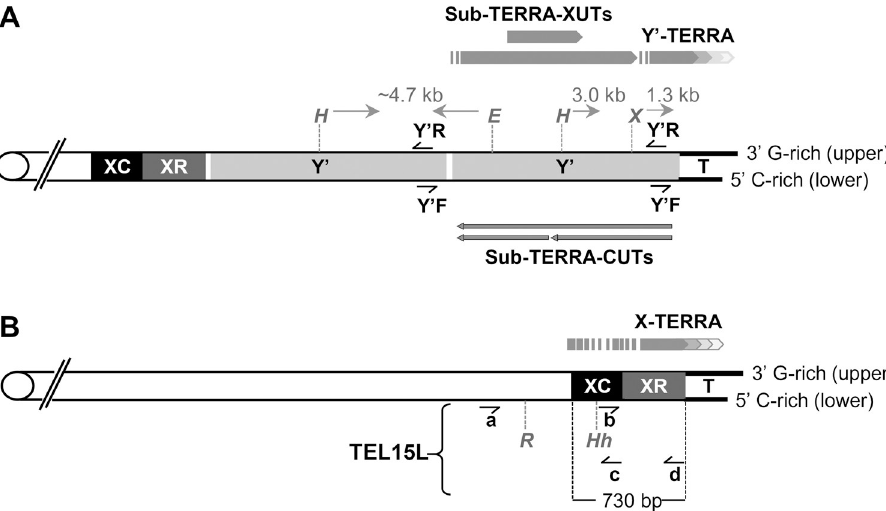
Fig 1. Maps of ncRNA transcription in Y’- and X-element telomeres. (A) Schema of a two copies Y’-element. Y’- elements (Y’) are located between the X-element, that is formed by the XC and XR regions, and the terminal repeats (T). Y’-elements can be of 2 types, long (6.7 kb) and short (5.2 kb). The terminal repeat consists of 325 ± 50 bp of imperfectly repetitive sequences